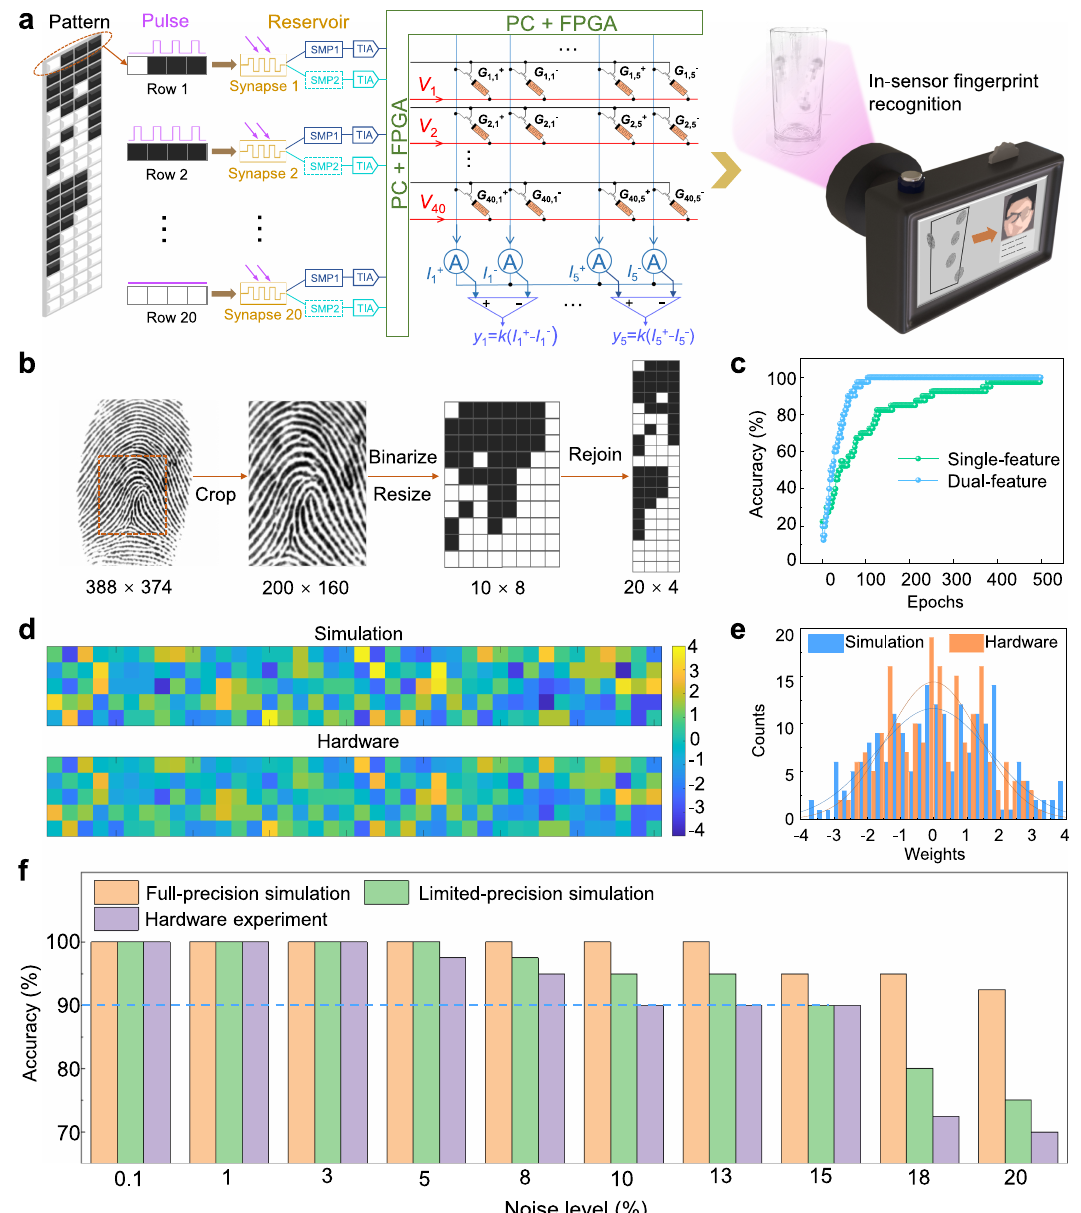
Fig. 4 | Fingerprint recognition based on hardware DUV in-sensor RC system. a Schematic of the proposed fully-hardware photoelectronic RC system for in- sensor fi ngerprint recognition, including photo-synapse reservoir layer which generates feature outputs, and memristor readout layer which performs network training. b Preprocessing method of the fi ngerprint images, including cropping, compressing,binarizing,andrejoining .c Theevolutionoftheaccuracyratesbased on single and dual features during readout network training. The training process